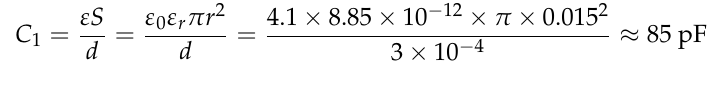
Figure 4. Determination of capacitance C 1 .